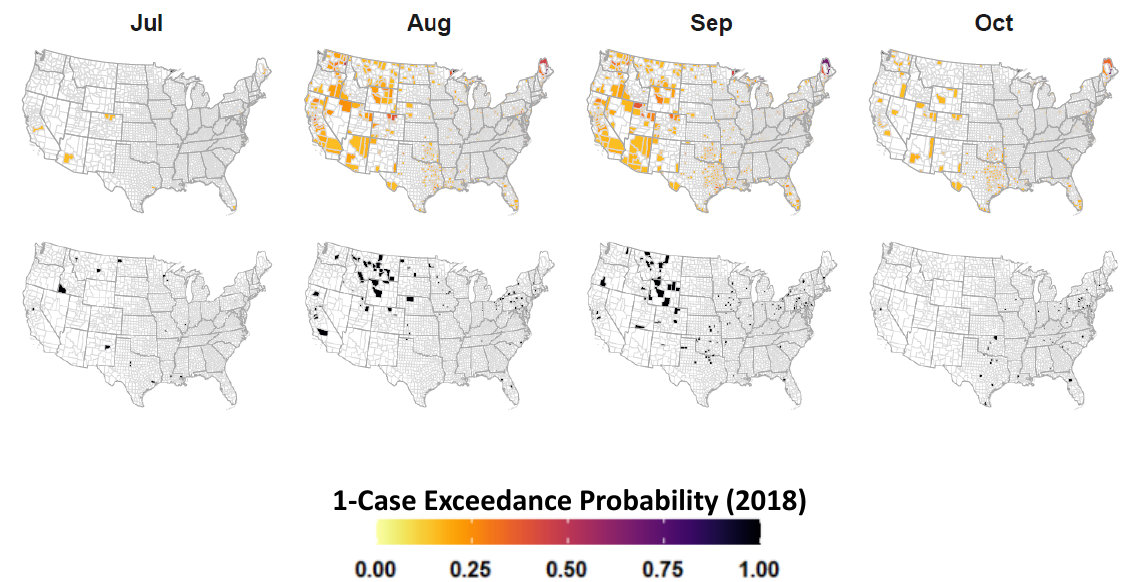
Figure A2. Model validation. Top row depicts out-of-sample, model predicted 1-case exceedance probability for the months July, August, September, and October 2018. Bottom row depicts locations of actual 1-case exceedance as reported to the